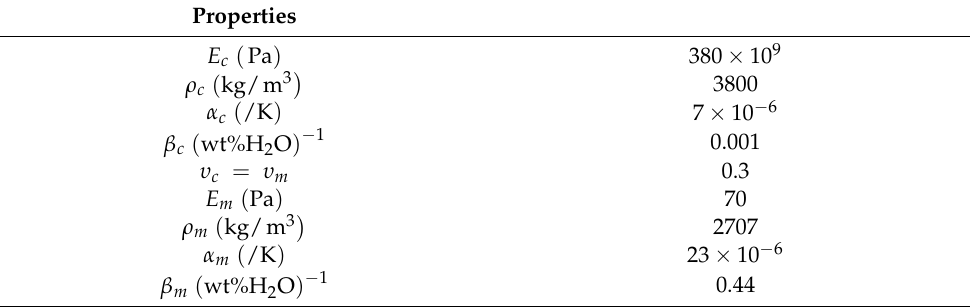
Table 2. Material properties of ceramic and metal [27].